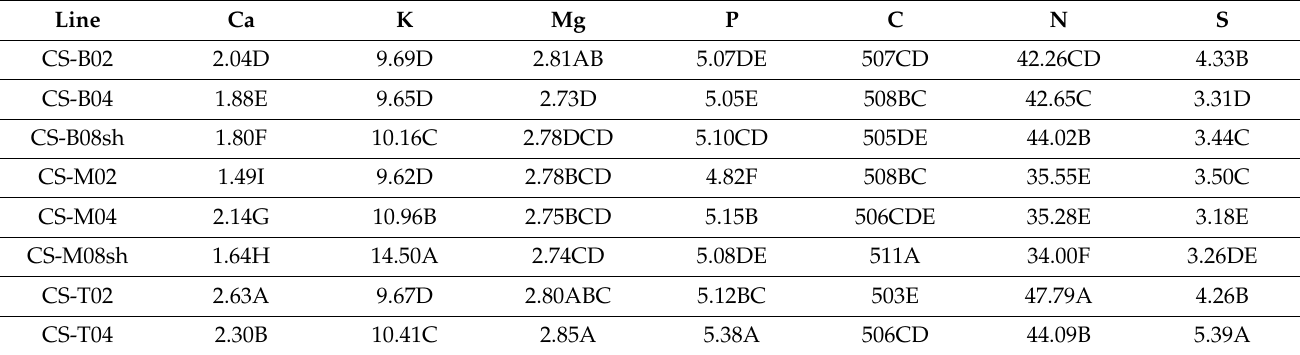
Table 2. Experiment 1: Effects of cotton chromosome substitution (CS) on cottonseed macronutrient concentrations (g kg − 1 ). The experiment was conducted in 2013 in Florence, SC,